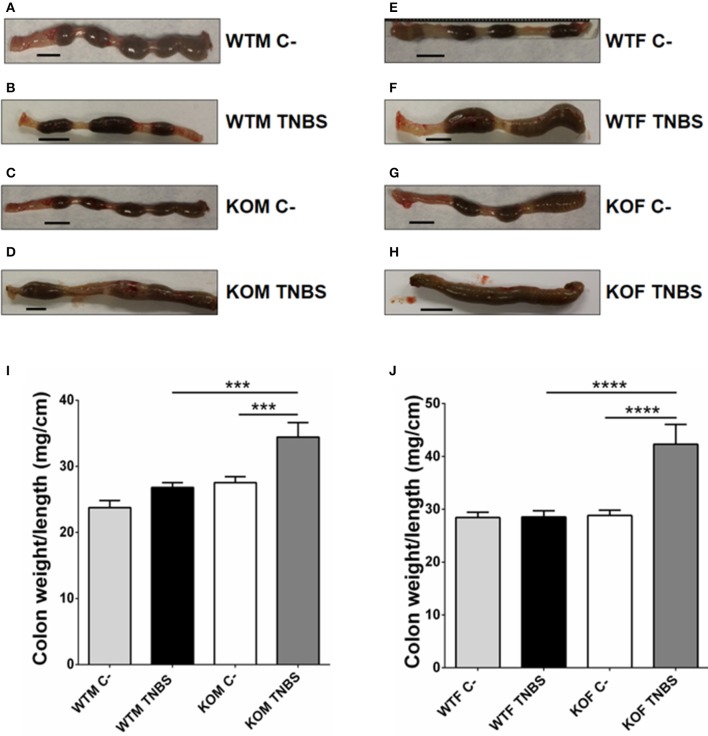
Macroscopic evidence of inflammation in TNBS-treated mice. Photographs of the last 5 cm of the colon (form the anus) from the 4 experimental groups in male (A–D) and female (E–H) mice, and relative weight of the colon (I,J) of the same animals. TNBS treatment did not alter the external aspect of the colon in the treated WTM group (B) but it caused local inflammation on the colon in KOM and the presence of diarrhea can be appreciated (D). In females, TNBS treatment caused clinical symptoms in WTF and their colons appeared more inflamed and the feces were semi-solid (F) when compared with feces of untreated (C-) WTF. KOF instilled with TNBS exhibited a more severe inflammation and the presence of diarrhea and bloody stools can be appreciated (H). A significant augmentation in the weight/length ratio of the colon can be observed in TNBS-treated KOM and KOF mice when compared with their respective controls and treated WT counterparts. (I,J) Data are shown as mean ± SEM. (I,J) One way ANOVA + Tukey's MCT. ***p < 0.001; ****p < 0.0001. Same groups as in Figure 1. Scale bar = 5 mm.